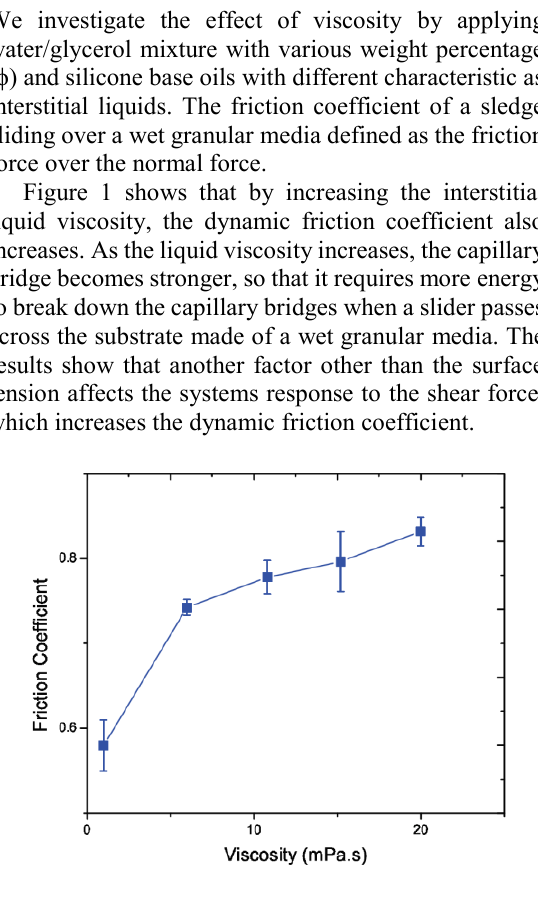
Fig. 1. Dynamic friction coefficient vs viscosity for water and glycerol mixture as the interstitial liquid in the sand. The volume fraction of the interstitial liquid (mixtures of pure water and glycerol) is fixed at 3% for all experiments. We use liquids with different viscosities but they have almost the same surface tension. As indicated in Table 1.